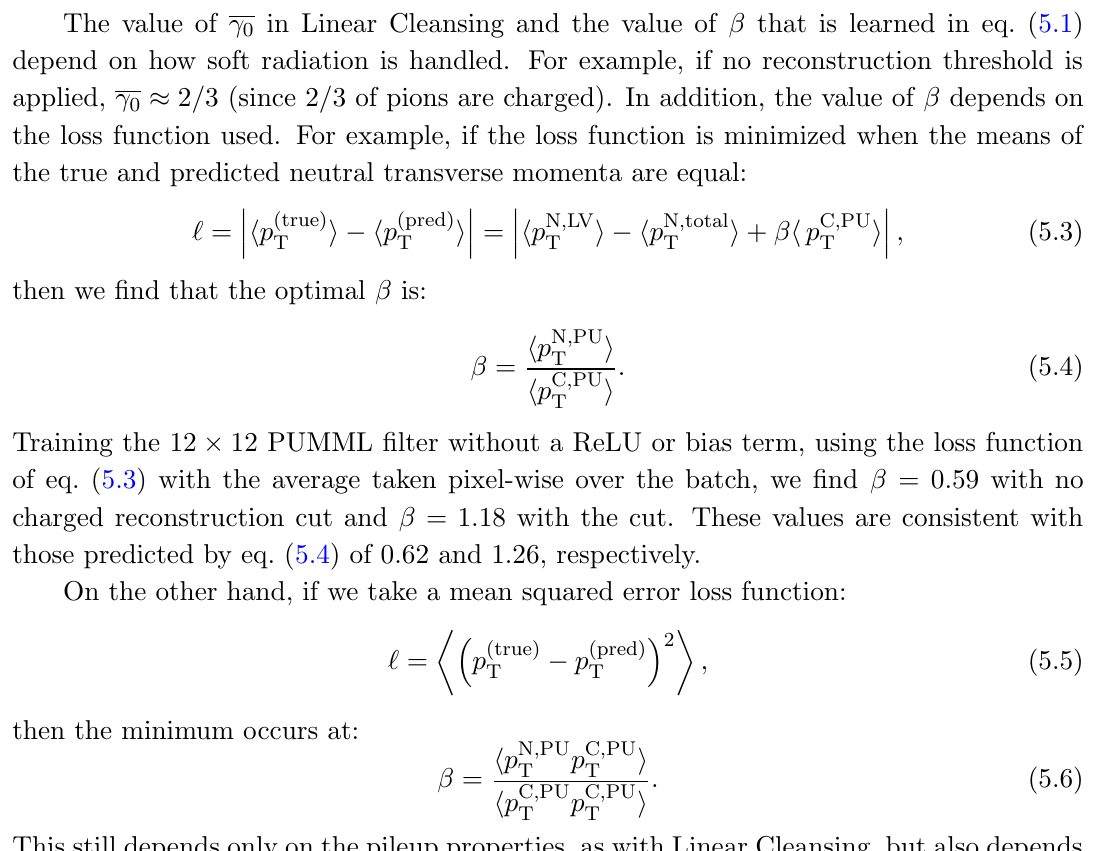
Figure 8 . Filter weights for a simple PUMML network with a single 12 (cid:2) 12 (cid:12)lter and a ReLU activation function trained with h NPU i = 140. The network has selected the relevant neutral pixel, turned o(cid:11) the charged leading vertex contribution, and is using the charged pileup information